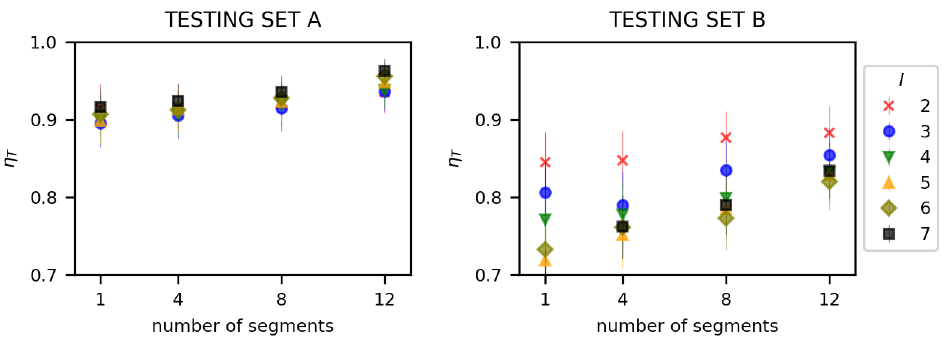
Figure 16. Number of segments impact on selection efficiency for Dataset A and Dataset